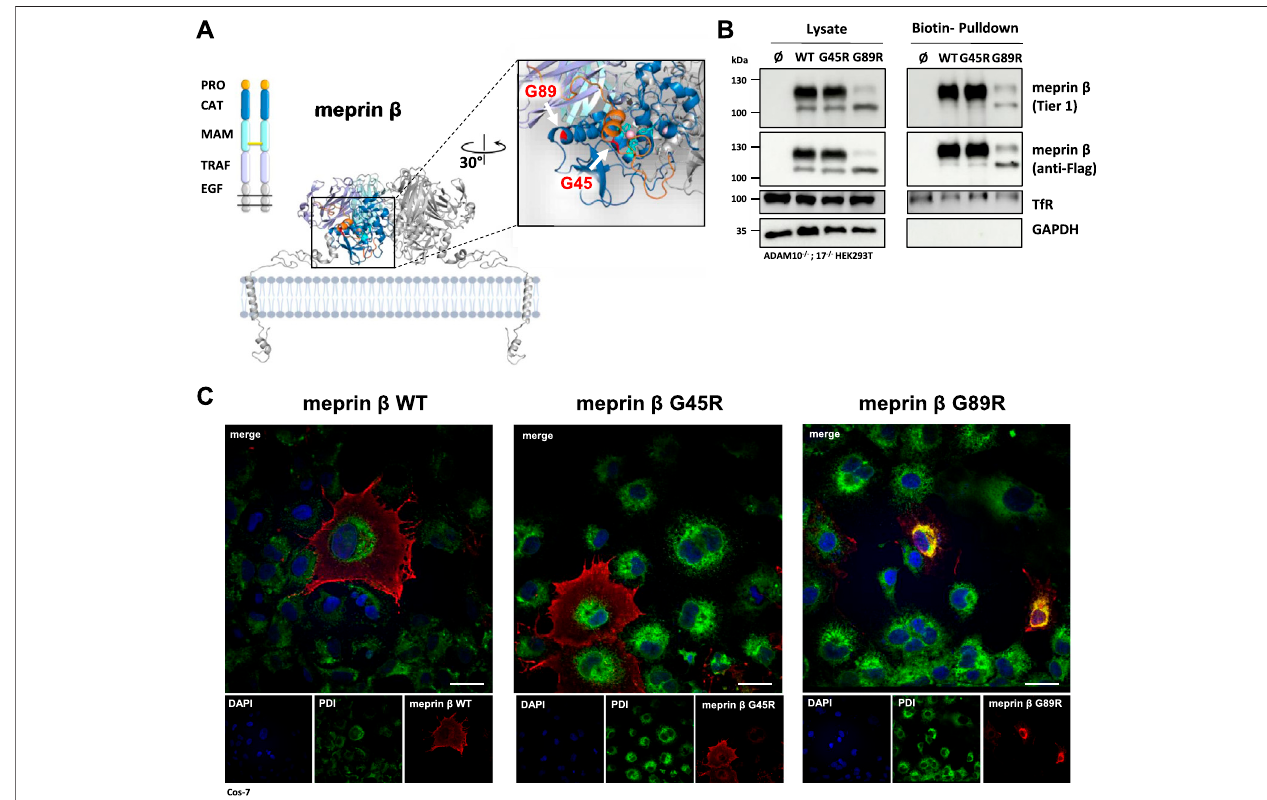
FIGURE 1 | Expression and localization of G45R, G89R, and wild-type meprin β . (A) Domain composition (left) and the dimeric structure of the metalloprotease meprin β (right). The cartoon representation of membrane-bound meprin β based on the crystal structure ofthe ectodomain ofhuman pro-meprin β (PDB: 4GWM), with one monomer coloredaccordingtothe domain compositionand theotherone inlightgray.The close-upview onthecatalytic domain (blue) inthe rightpanel shows the pro-peptide (orange) and the three active site histidine residues (cyan) that coordinate the zinc ion (pink). The positions of the two amino acid exchange variants G45R and G89R are highlighted in red. Pro-peptide, CAT: catalytic domain, MAM: meprin A5 protein tyrosine phosphatase µ domain, TRAF: tumor-necrosis-factor- receptor-associated factor domain, EGF: epidermalgrowth factor – likedomain. Thedisul fi debridge between theMAM domains responsiblefordimerization isindicated as a yellow bar. (B) Transfection of ADAM10 − / − ; 17 − / − HEK293T cells with the indicated meprin β variants. Cell surface proteins were labeled by primary amine biotinylation,pulleddownwithstreptavidinsepharosebeads,andanalyzed via immunoblotting.GAPDHandtransferrinreceptor(TfR)servedastheloadingcontrols. (C) Immuno fl uorescence images of Cos-7 cells expressing the indicated meprin β variants (red), with the endoplasmic reticulum marker protein disul fi de isomerase (PDI, green) and DAPI-stained nuclei (blue). Scale bars, 20